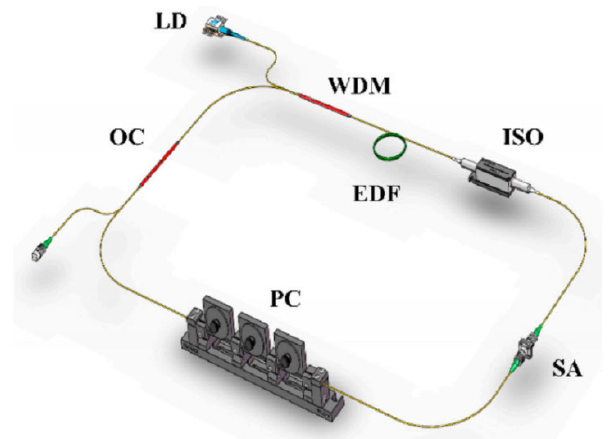
Figure 15. Schematic diagram of laser cavity connection. Reprinted with permission from Ref. [27]. Copyright 2021, Optical Materials.